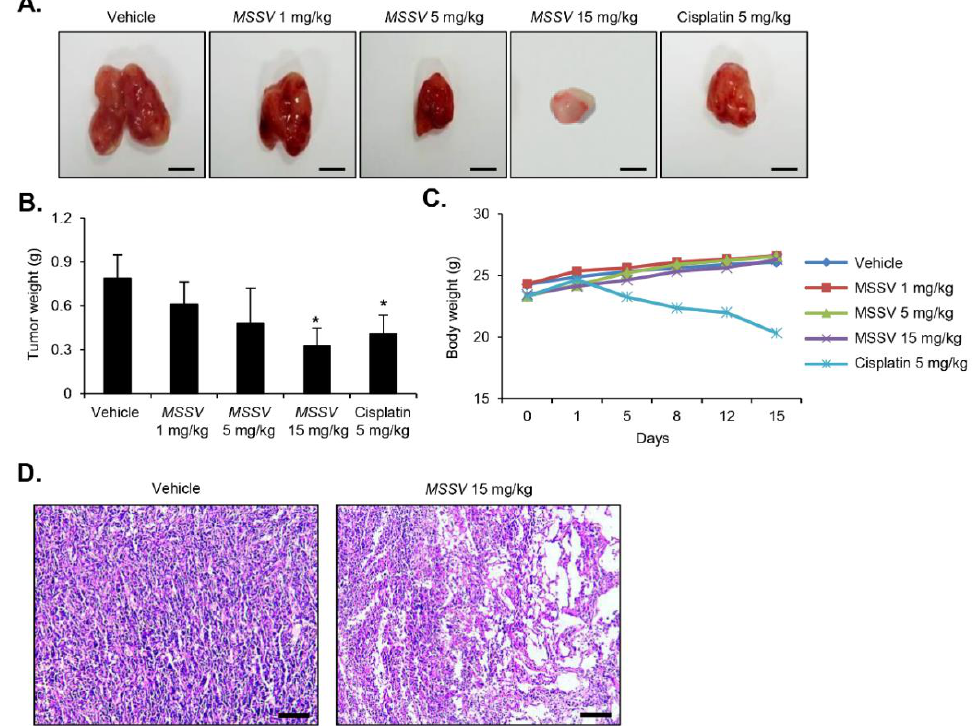
Figure 6. Antitumor efficacy of MSSV in bladder cancer 5637 xenograft mice models. ( A ) MSSV administration via oral gavage twice a day caused the inhibition of tumor growth in bladder cancer-xenografted mouse model (scale bars = 50 mm). ( B , C ) Tumor weight and body weight are represented in the bar graph. All data are represented as the means ± SE from three independent experiments. * p < 0.05, compared with control. ( D ) Tumor tissues were subjected to H&E staining for the detection of tumors (scale bars = 50 µm).